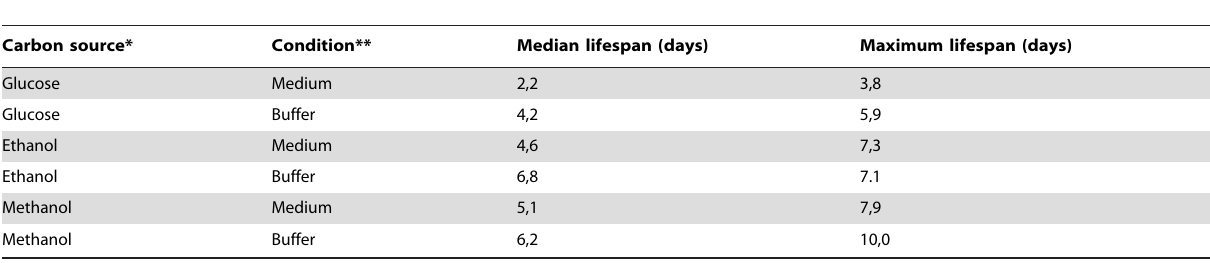
Table 1. The effect of buffer on median and maximum lifespan of H. polymorpha